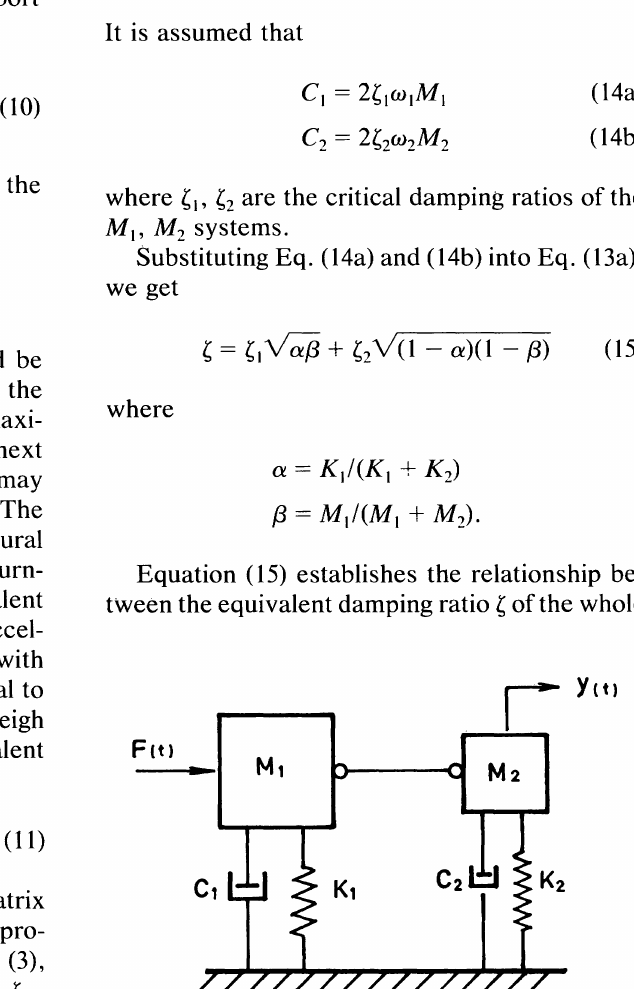
FIGURE 3 Model of two-mass